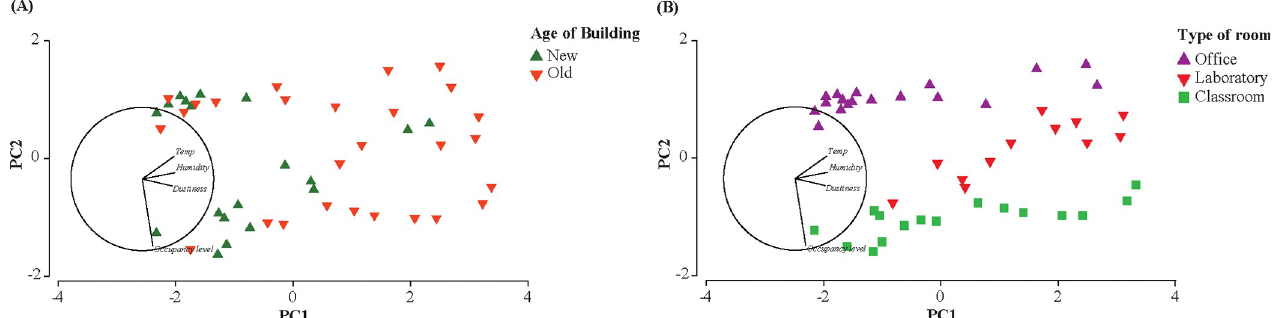
Fig 3. Principal component analysis (PCA) plot. PCA with the random variables of temperature, humidity, dustiness, and occupancy level and the controlled variables of (A) age of building and (B) type of room for the 51 rooms sampled. Axes are the principal component, PC1, and PC2, with loading values.